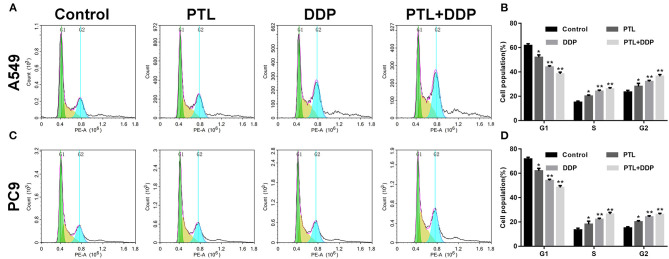
Effect of PTL and DDP alone and in combination on cell cycle arrest. The percentage of cells in the G1, S, or G2 phase in A549 (A) or PC9 cells (C) treated with 30 μM PTL, 0.75 μM DDP alone, and 0.2 μM DDP and 10 μM PTL in combination for 48 h. Data represent the cell population in cell cycle arrest of A549 (B) and PC9 (D) cells. All data are shown as the mean ± SD of three independent experiments. *P < 0.05, **P < 0.01 vs. the control group.